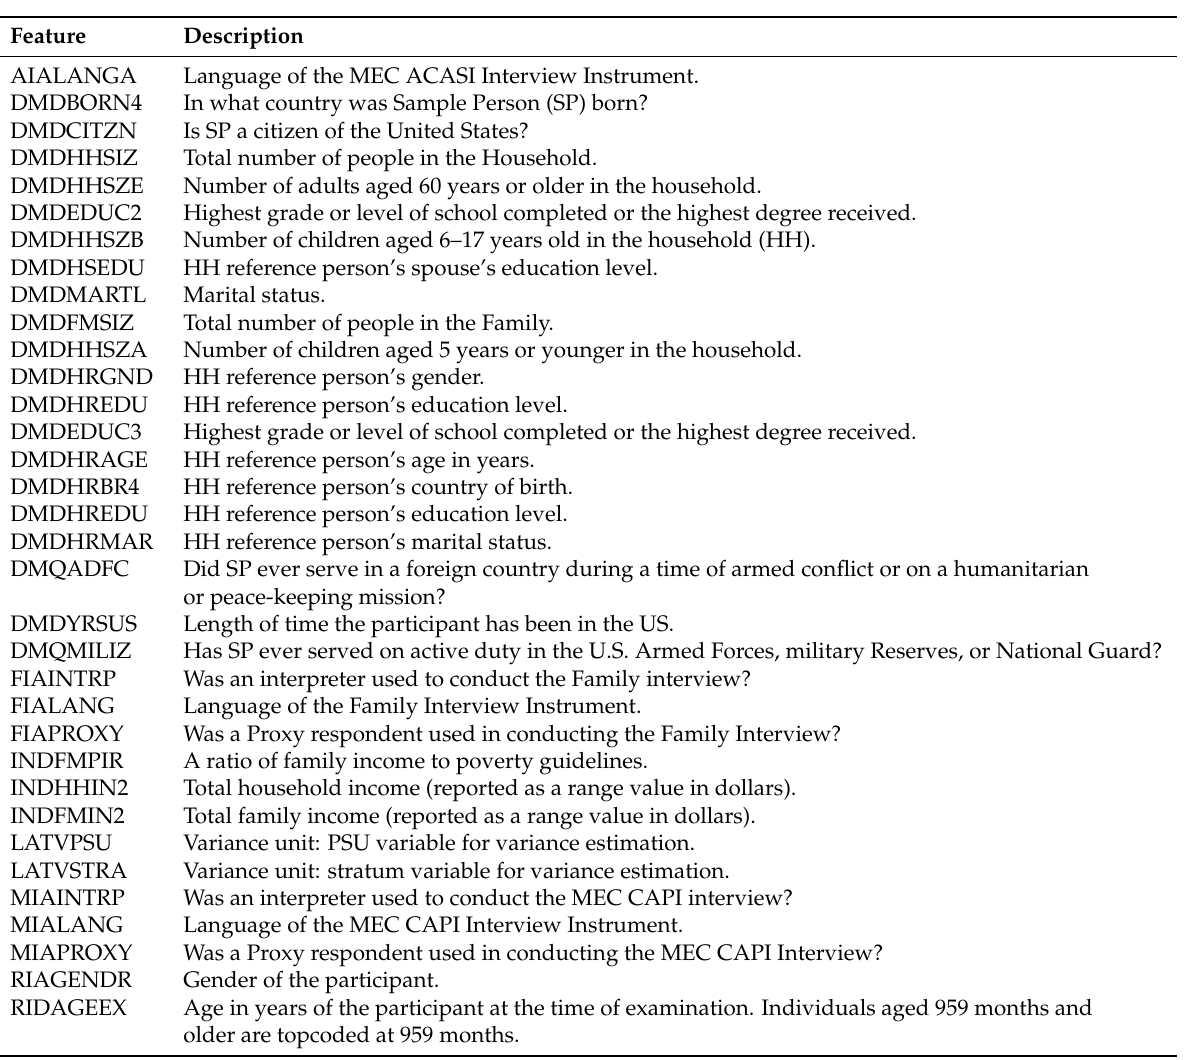
Table A1. Description of demographic